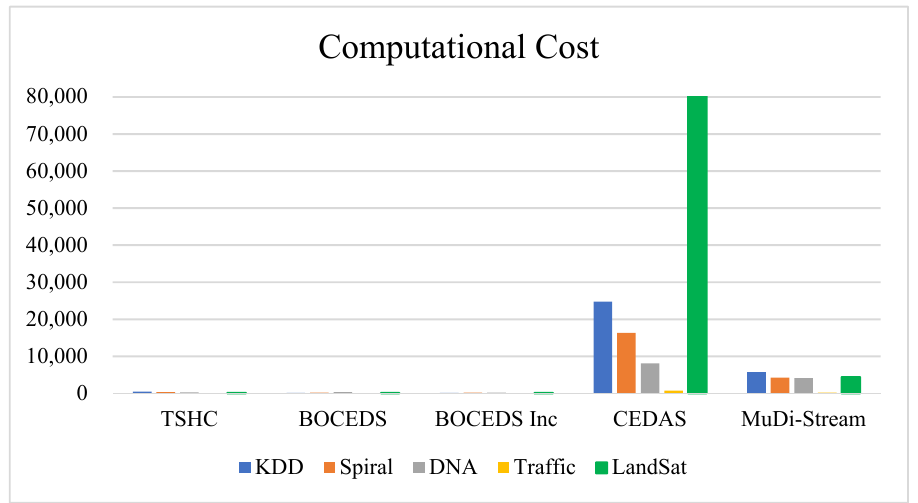
Figure 9. Computational Cost Comparison using KDDCup’99, Landsat, Spiral, DNA, and Traffic Datasets.